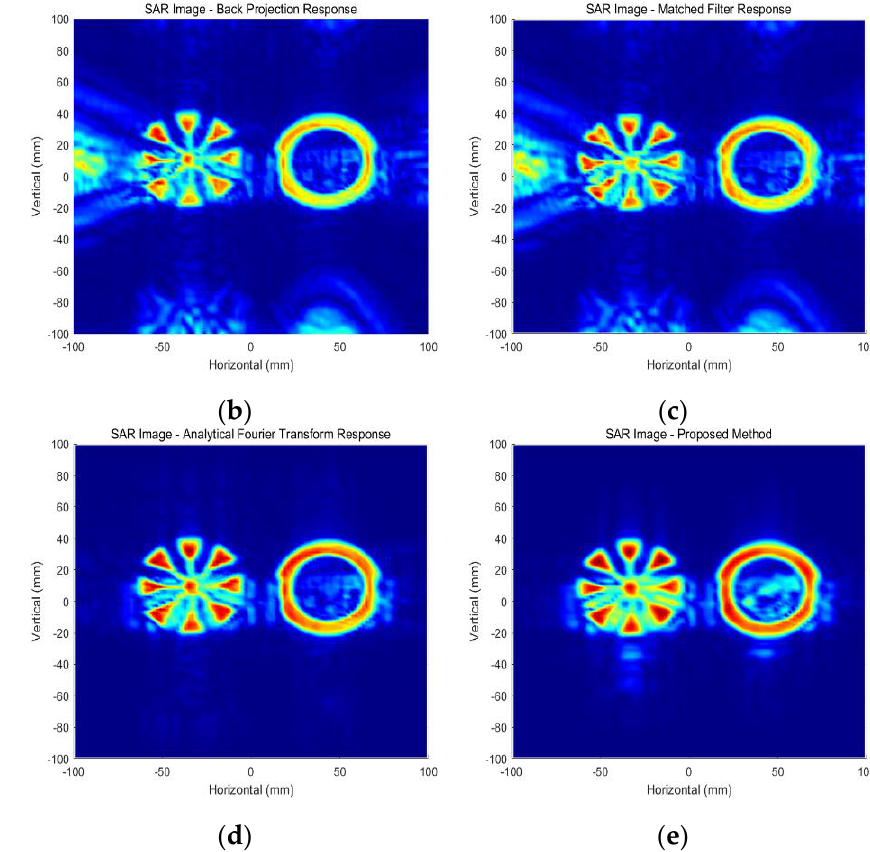
Figure 10. Same-Distance multiple targets: ( a ) real scenario; ( b ) Back Projection; ( c ) Matched Filter; ( d ) Analytic Fourier Transform; ( e ) mmSight.